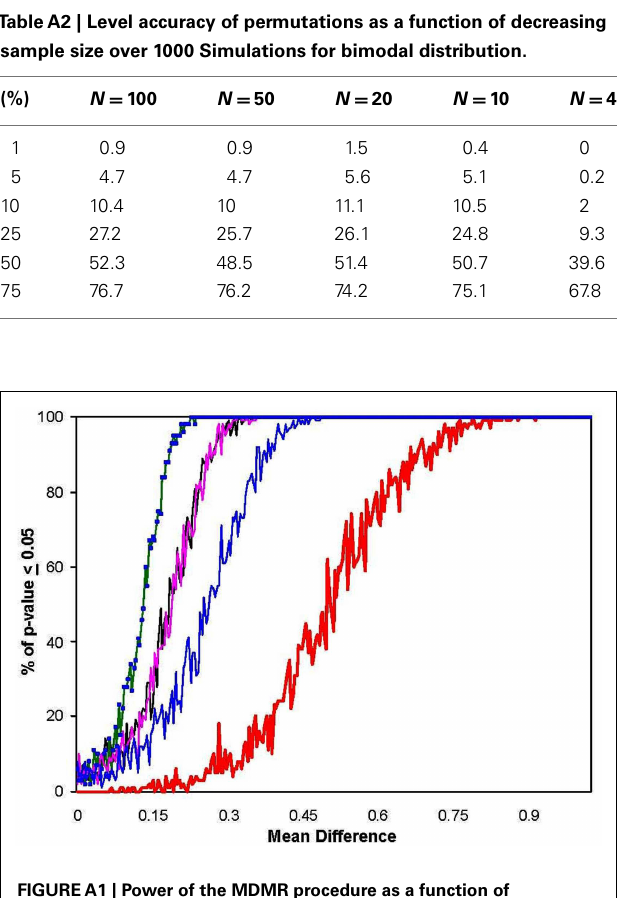
FIGUREA1 | Power of the MDMR procedure as a function of non-normal population distributions. The black line shows power as calculated before for two populations with normal distributions.The green line displays power for populations with log normal distributions.The pink line shows power for power for populations with bimodal distributions (equivalent for a normal distribution with 100% of the data having means altered) and the blue line shows power when only one mode of a bimodal population is different (equivalent for a normal distribution with 50% of the data having means altered).The red line shows the power of a Bonferroni corrected p -value for the Student’s t -tests performed on each of the 100 variables in univariate t -tests which were corrected for the 100 statistical tests pursued.